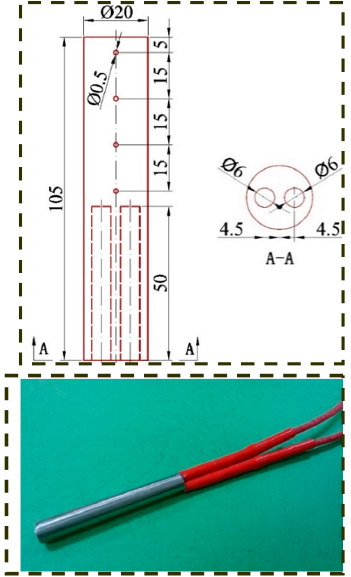
Figure 4. Structure of copper block and heating rods (unit: mm).